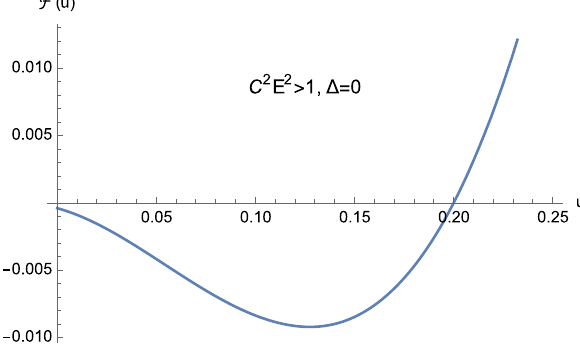
Fig. 8 The positive root Eq. (2.20) when C 2 E 2 > 1 and (cid:9) =